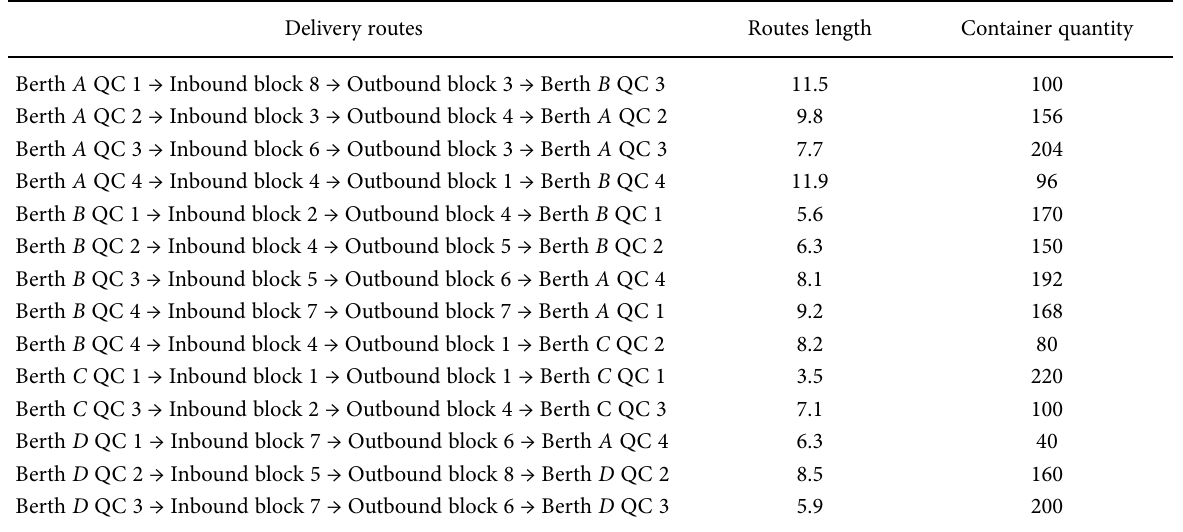
Table 2. Optimized routes of yard trailers